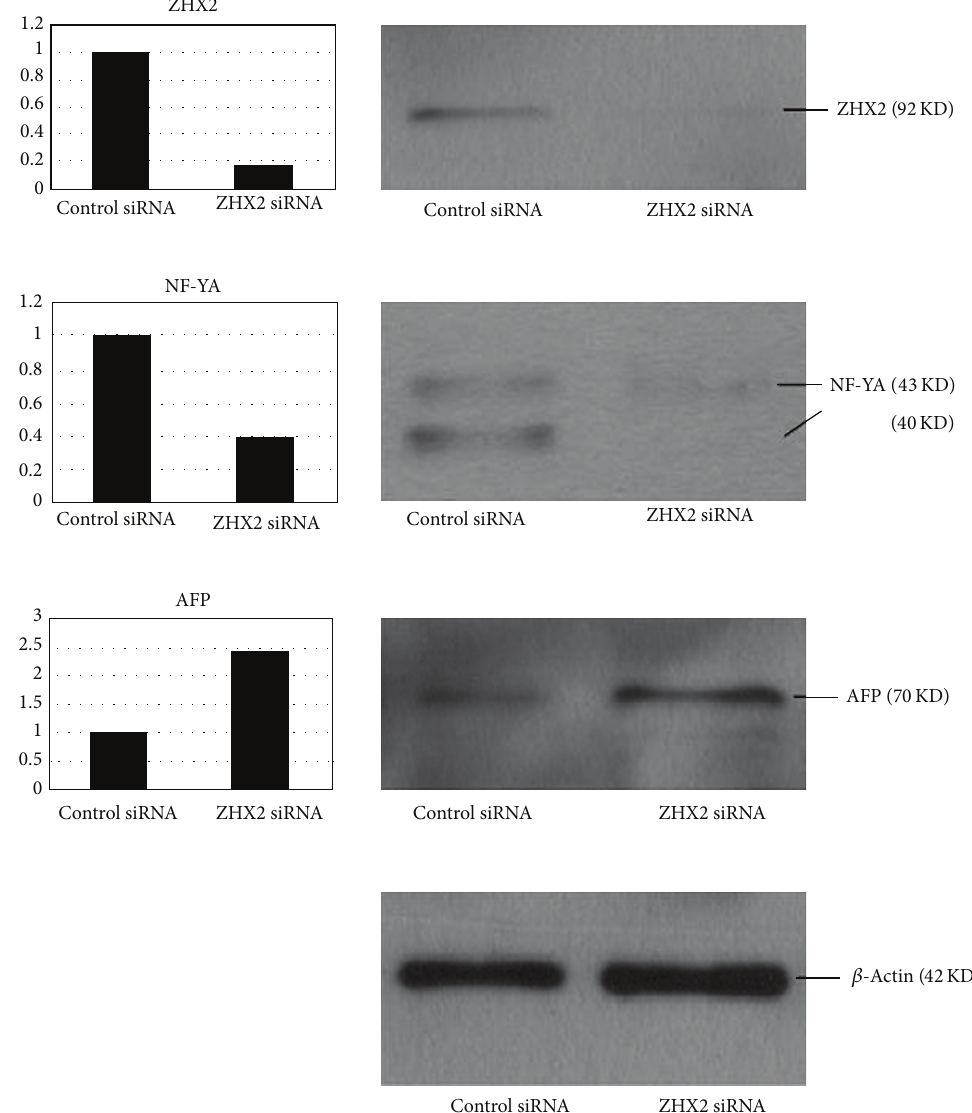
Figure 3: Expression of zinc fingers and homeoboxes 2 (ZHX2), nuclear factor-YA (NF-YA), and alpha-fetal protein (AFP) in HepG2 cells after siRNA transfection. The target protein expression was detected by Western blot analysis. The expression of 𝛽 -actin was analyzed as an internal control. The amounts of protein in the ZHX2 siRNA-treated cells were compared to those of control cells. After siRNA transfection, ZHX2 protein expression (92KD) was decreased by 83%, NF-YA protein expression (40KD and 43 KD) was reduced by 61%, and AFP protein expression (70 KD) was increased by